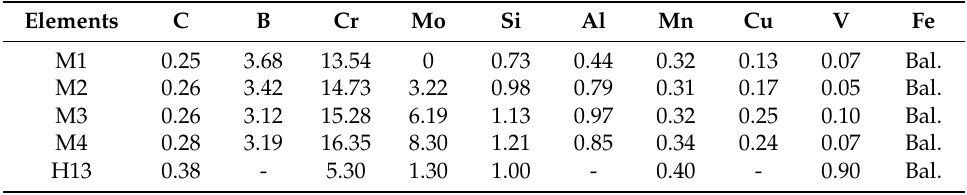
Table 1. Chemical compositions (in wt.%) of Fe-Cr-B cast steels and the H13 steel.